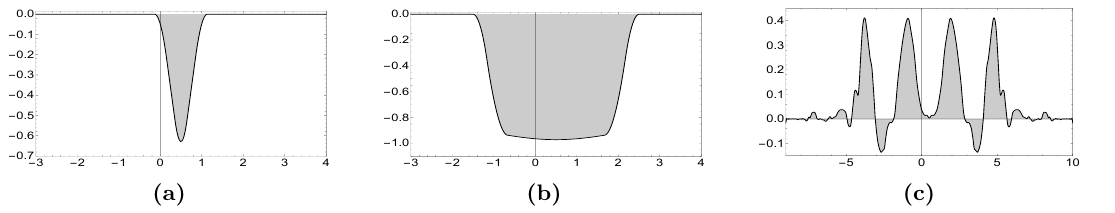
Figure 27. Numerical solutions in the perturbed model for (cid:15) = 10 : 0 at (a) t = 0 : 15, (b) t = 1 : 67, (c) t = 20 : 79.